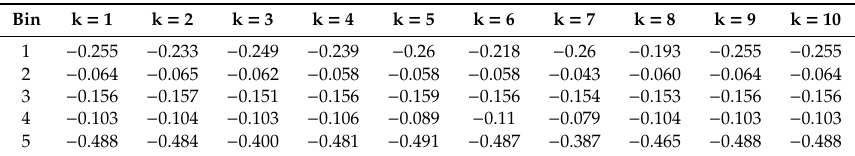
Table A1. Bias value for CAISO method.